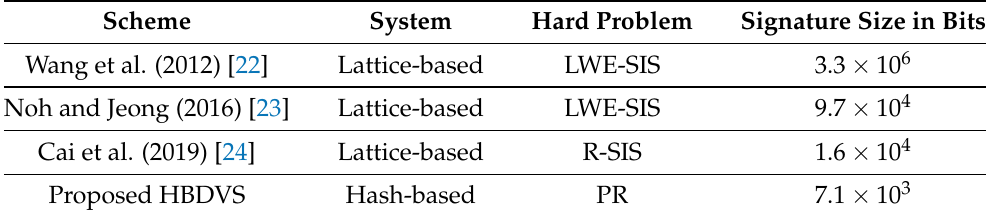
Table 1. Comparison of HBDVS scheme with existing DVS